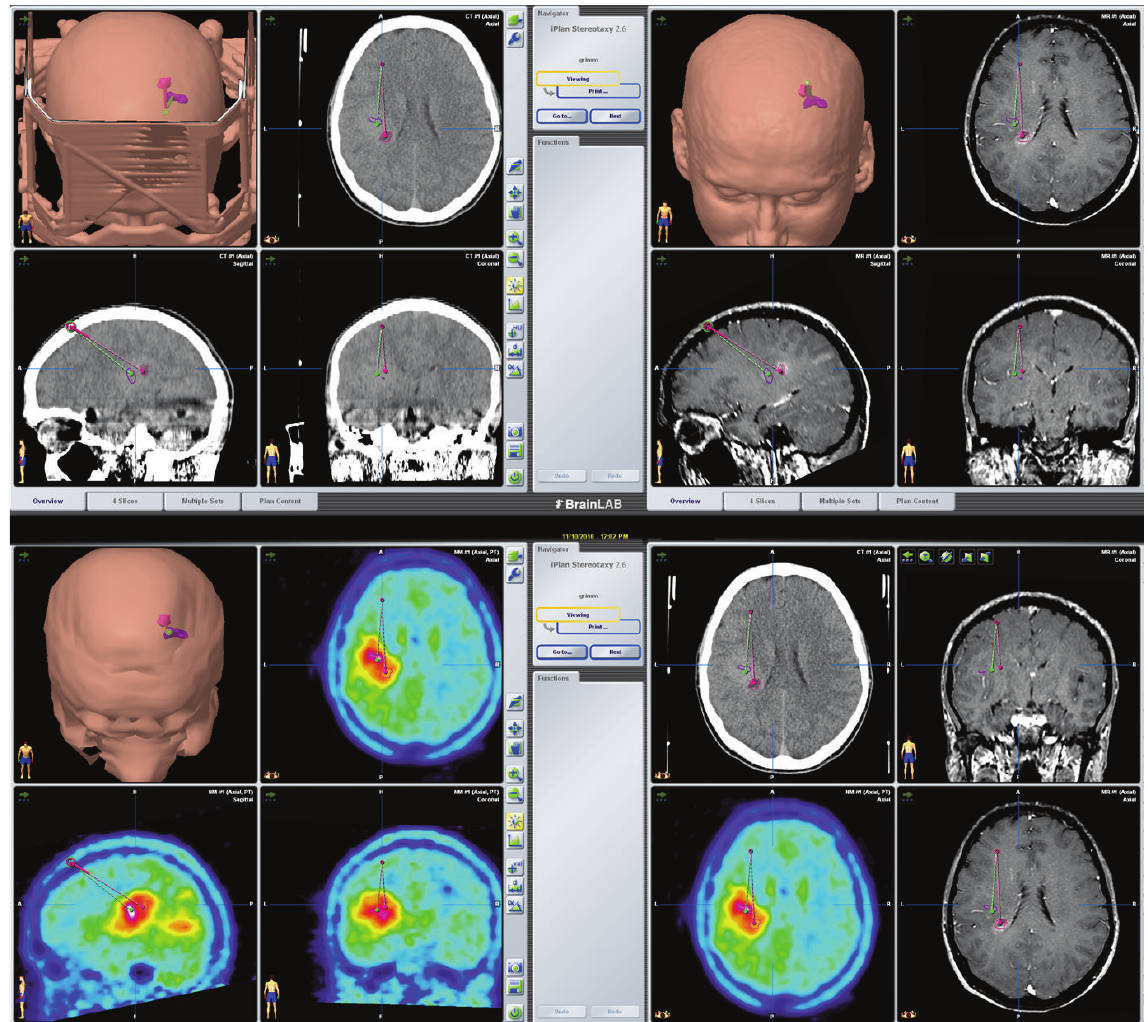
Figure 5: Presurgical navigational overlay of CT, MRI, and FDG-PET in a patient prepared for a stereotactic biopsy. The CT images showed only minor changes, the T1 weighted contrast-enhanced MRI showed a very small contrast a ffi ne region but a large hypermetabolic lesion in the left parietal brain was revealed by PET, helping to define the best biopsy aim and